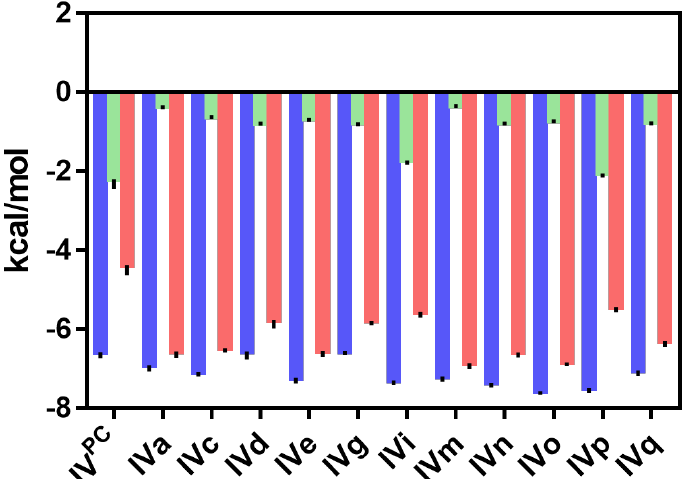
Figure 3. Thermodynamic binding profile of IV PC and IVx analogues for which a significant (Δ T m > 5 °C) thermostabilizing effect was observed: binding Gibbs energy (blue), binding enthalpy (green) and entropic contribution ( − T × Δ S ) to binding Gibbs energy (red) obtained from ITC experiments.